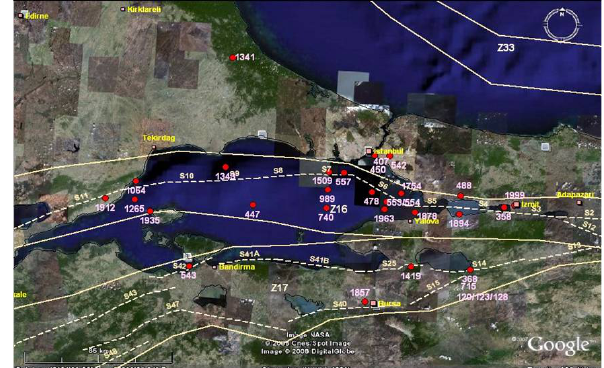
1 Figure 1. Tsunamigenic seismic zonation map for Turkey. Zones are shown by green 2 Fig. 1. Tsunamigenic seismic zonation map for Turkey. Zones are polygons and red dots represent the individual point sources as the epicentres of the 3 shown by green polygons and red dots represent the individual point earthquakes that produced tsunamis in the past. 4 sources as the epicentres of the earthquakes that produced tsunamis in the past.